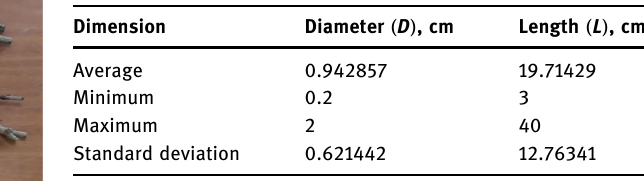
Table 3: Wooden trunk characteristics